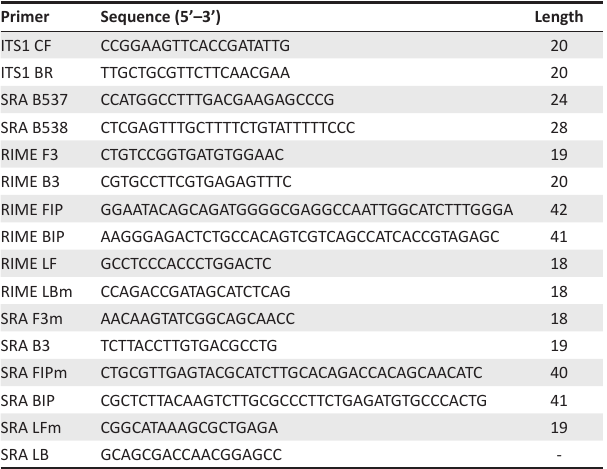
TABLE 1: Nucleotide sequences of internal transcribed spacer 1-polymerase chain reaction and repetitive insertion mobile element loop-mediated isothermal amplification